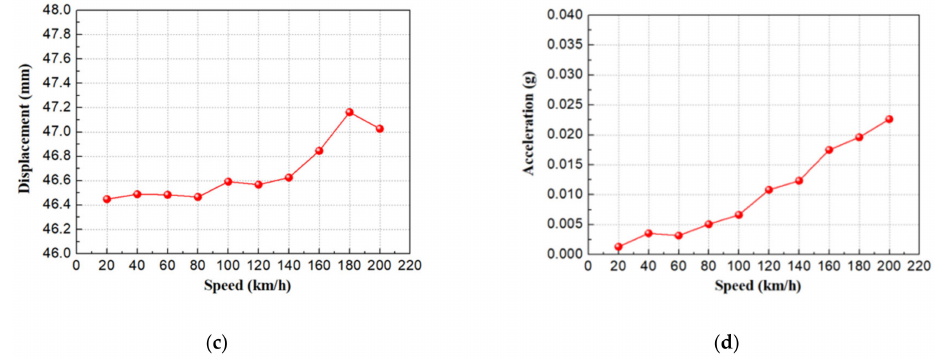
Figure 13. Prediction of dynamic behavior of the bridge according to increasing train speed. ( a ) Bridge deck displacement (truss bridge); ( b ) Bridge deck acceleration (truss bridge); ( c ) Bridge deck displacement (suspension bridge); ( d ) Bridge deck acceleration (suspension bridge).